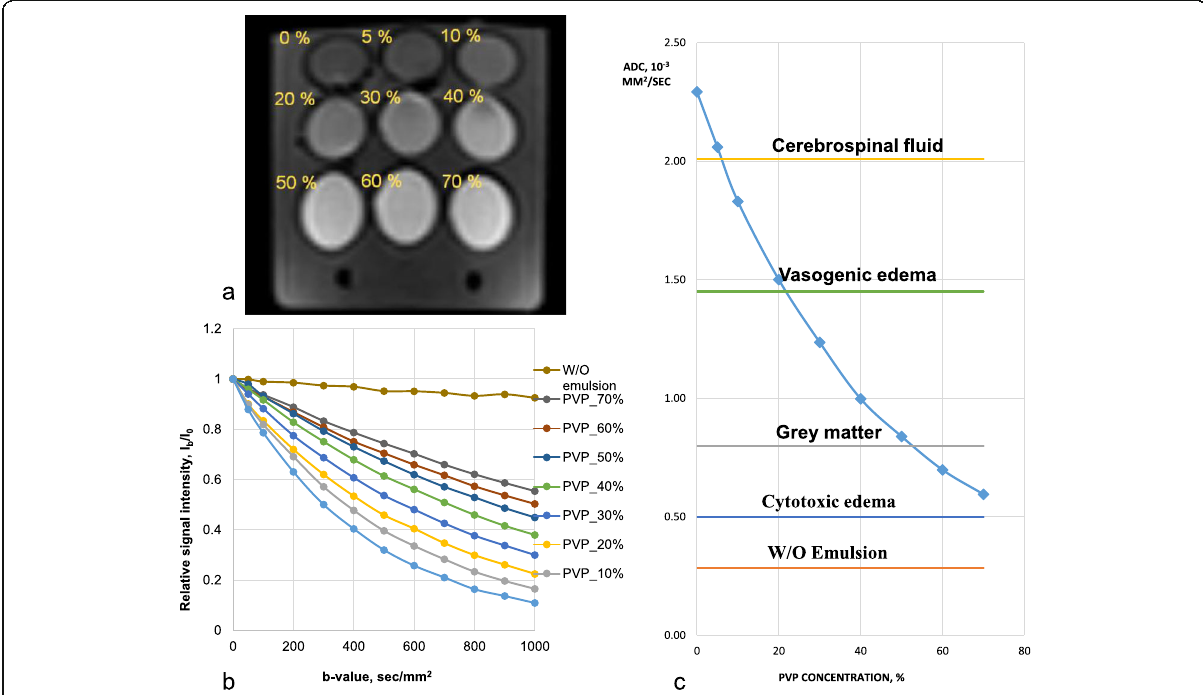
Fig. 4 QA-DWI phantom. a DWI of the phantom with PVP aqueous solutions ( b value 500 s/mm 2 ). b , c The dependence graphs of QA-DWI quantitative parameters with b being the signal attenuation dependency from b value and c being the ADC distribution for control substances with values for some normal tissues and pathological